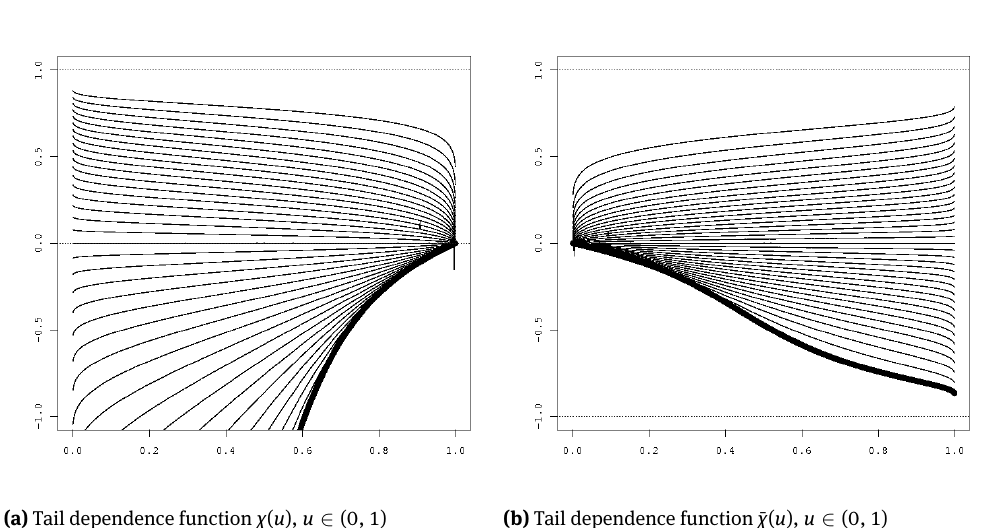
Figure 1: Tail dependence functions for the Gaussian dependence model. The curves (bottom to top) correspond to correlation coefficient ρ = −0.95, −0.90, −0.85, . . . , 0.90, 0.95 . In dotted line, the upper and lower bounds on χ (.) and ¯ χ (.)